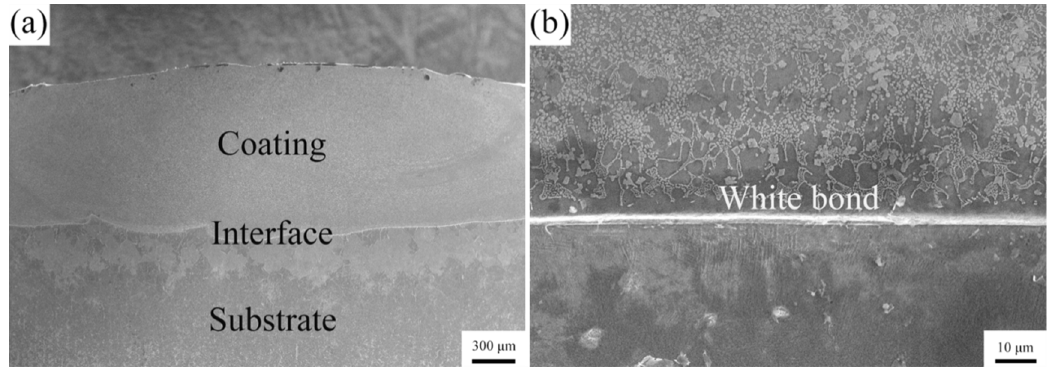
Figure 2. ( a ) The cross-sectional macro-morphology of Coating III; ( b ) the interface between Coating III and the substrate.